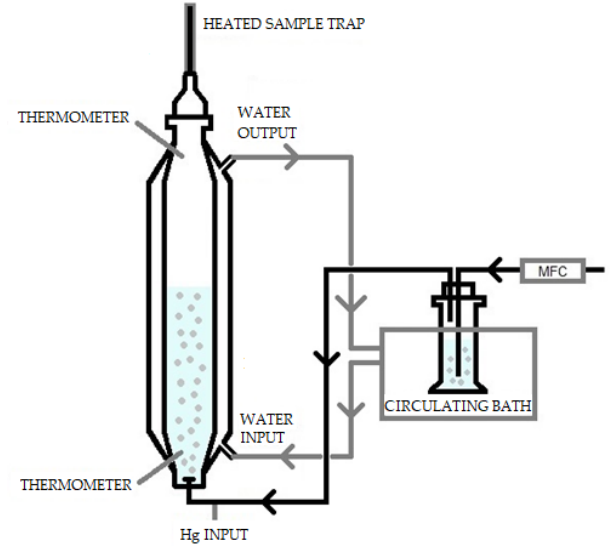
Figure 3. Henry law extractor stripping vessel